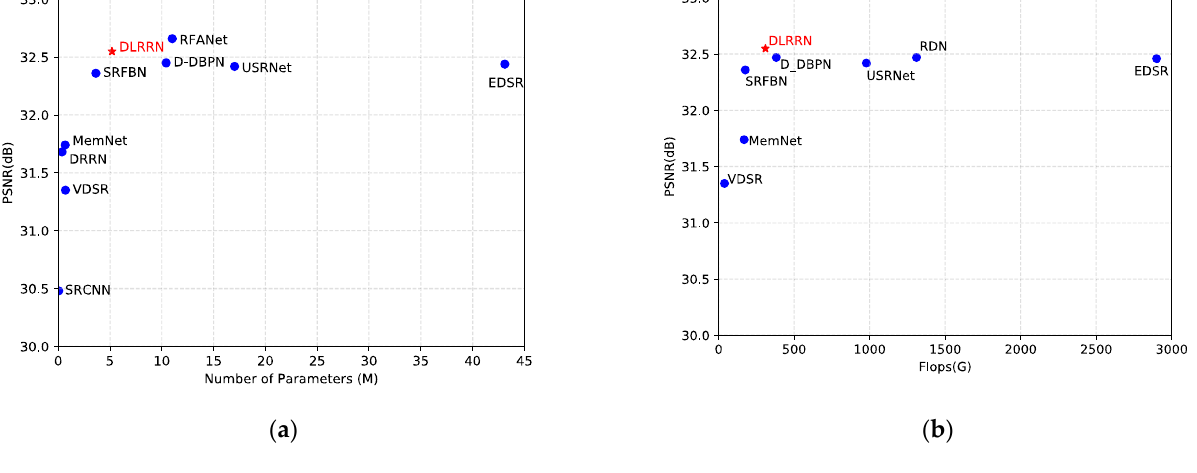
Figure 10. ( a ) PSNR and parameters. The results are the BI × 4 evaluated on Set5. Red points indicate our proposed network and achieved relatively optimal performance. ( b ) PSNR and Flops. Flops are computed on 720p HR